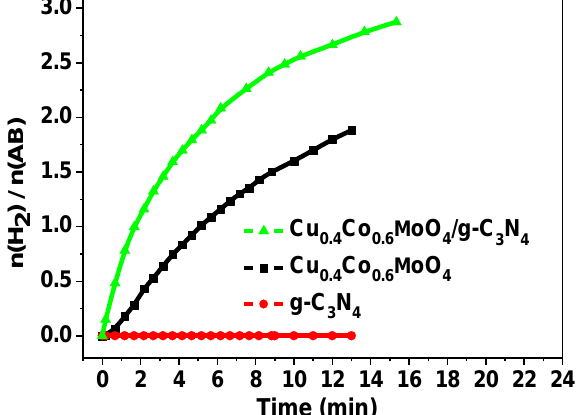
Figure 5. Time vs. n (H 2 )/ n (AB) during the catalytic hydrolysis of ammonia borane (AB) with catalysts Cu 0.4 Co 0.6 MoO 4 , g-C 3 N 4 and Cu 0.4 Co 0.6 MoO 4 / g-C 3 N 4 Cu 0.4 Co 0.6 MoO 4 , g-C 3 N 4 and Cu 0.4 Co 0.6 MoO 4 /g-C 3 N 4 .